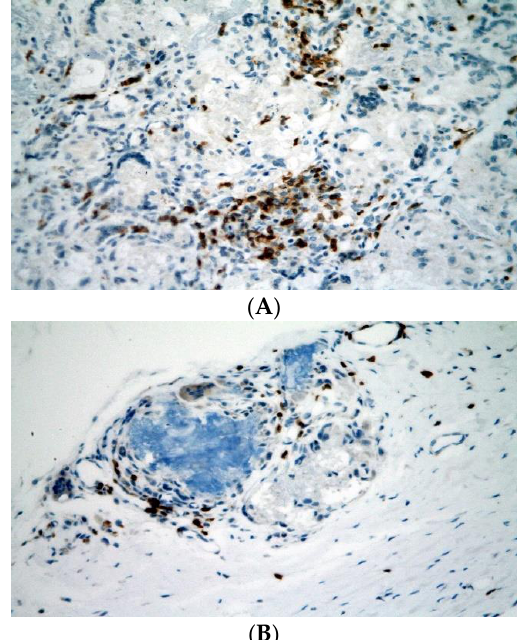
group A and 16 in group B ( p = 0.0057) (Table 1 and Figure 4A,B). TRAP + cells were ob- served in all specimens (Table 1 and Figure 5A,B). CHAE+ neutrophils, CD20+ B-lympho- cytes, and eosinophils were absent in all specimens.